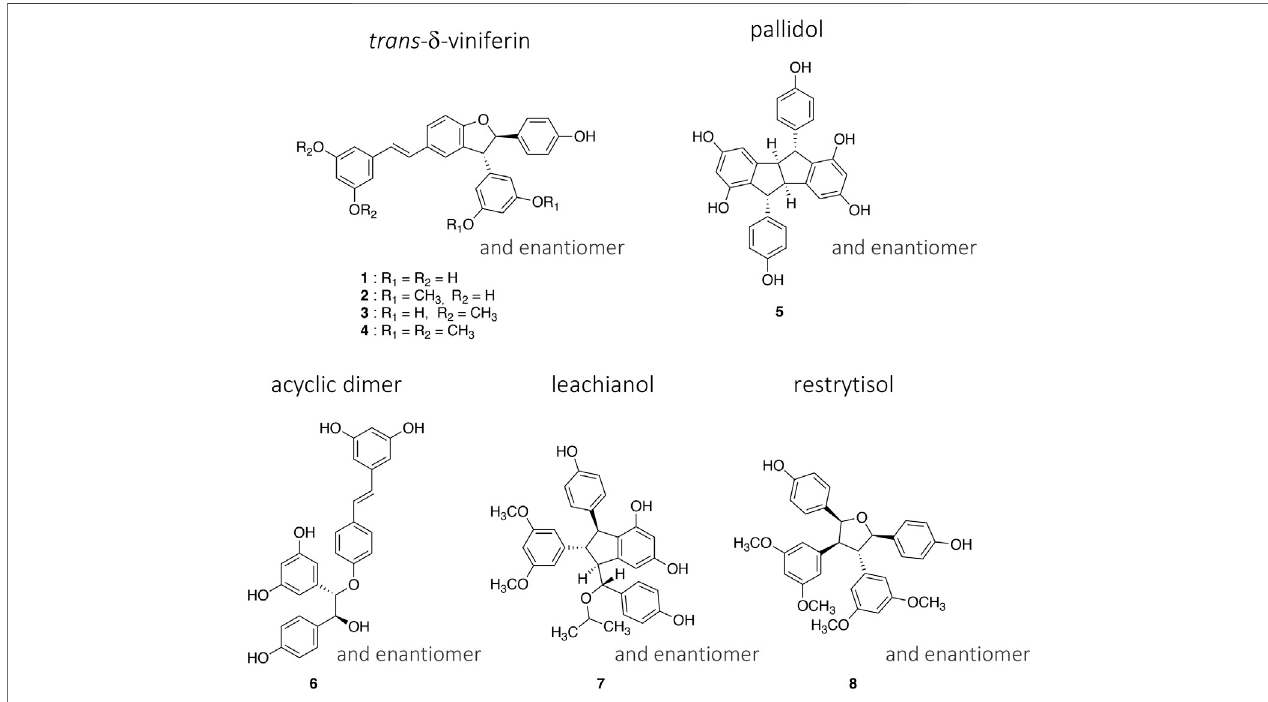
FIGURE 1 | Structures of the four trans - δ -viniferin derivatives ( 1 – 4 ) and the four other selected compounds ( 5 – 8 ) representing the main scaffolds obtained by the biotransformation of resveratrol and pterostilbene with the enzymatic secretome of Botrytis cinerea Pers.